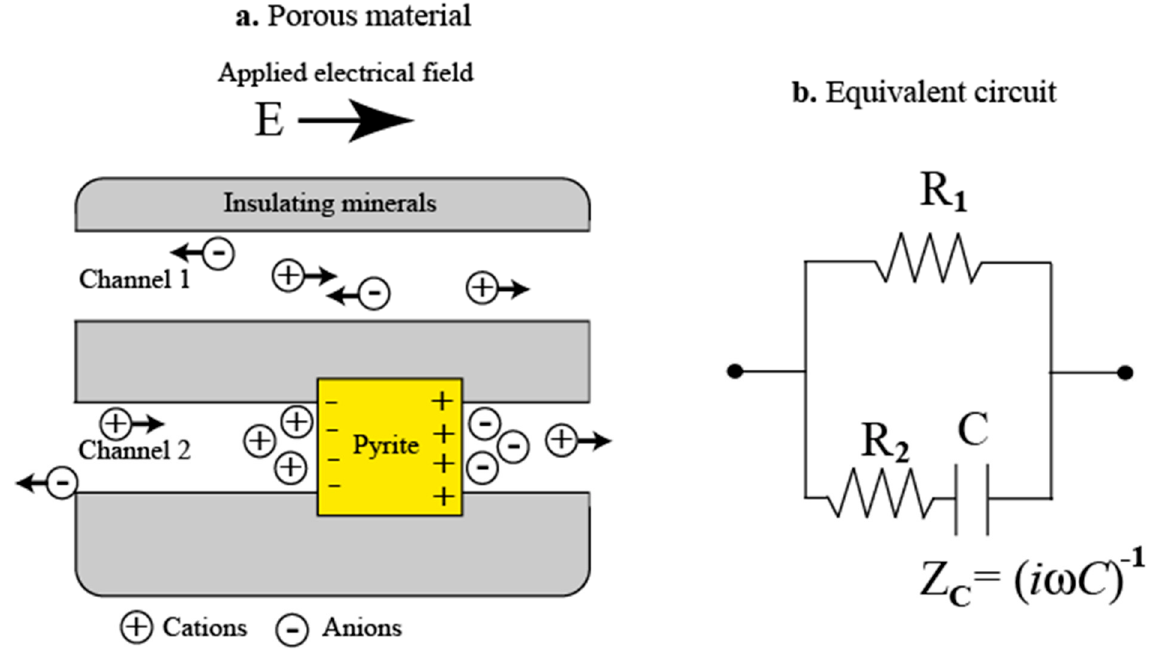
Figure 22. Representation of the equivalent circuit of a mineralized rock in classical textbooks and papers. ( a ) The rock is composed of two types of pores or channels: one with ions free to move (Channel 1), and a second one with a pyrite grain and a blocking effect of the charge carriers at the interface between the metallic particle and the free pore water (which is an electrolyte with cations and anions). ( b ) Equivalent electric circuit that facilitates the response calculation in the time and frequency domains. For historical reasons, the polarization that is associated with the blocking of the charge carriers at the surface of the metallic grains is named the “electrode polarization”, which is characterized by a capacitance ( C ) with an impedance that is written as “ Z C ”.